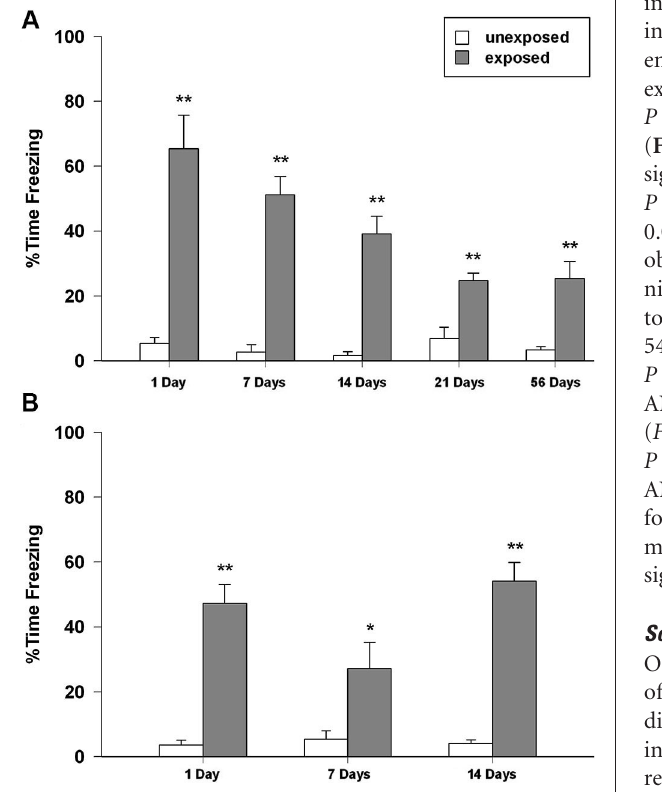
FIGURE 3 | Percentage of time spent in freezing of rats exposed to the context and not shocked (unexposed) or exposed to the context and given five inescapable footshocks (exposed) during the re-exposure sessions performed 1, 7, 14, 21 and 54 days after the exposure ( n = 8–11). (A) Isolated, (B) social-housed animals. Data are expressed as mean + SEM (* p < 0.05; ** p < 0.01; EXP vs.